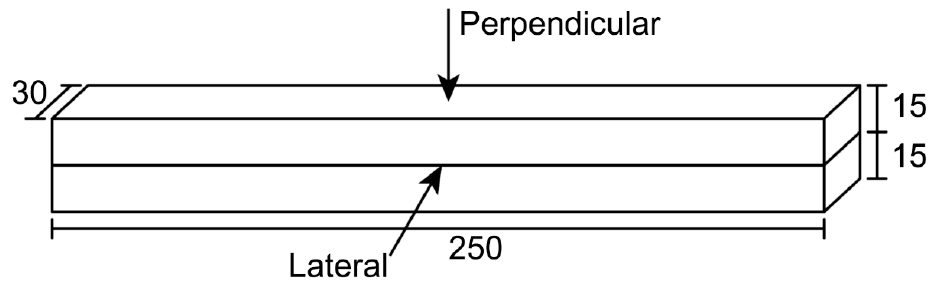
Figure 5. Testing directions for the flexural test of the two-layer optimum 3D printed geopolymer mix.